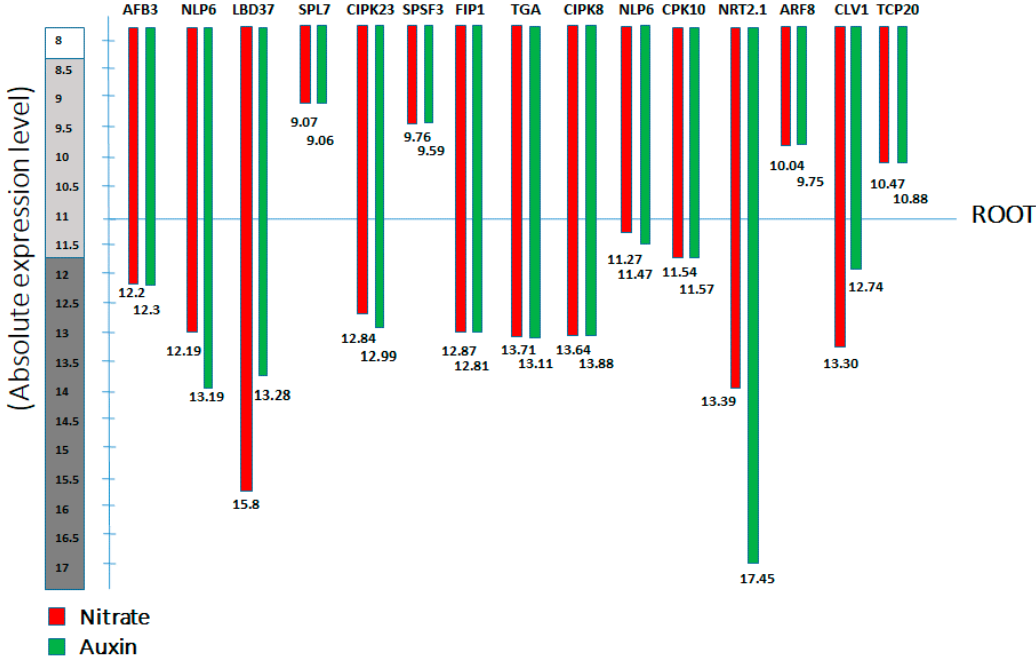
Figure 5. Affymetrix Arabidopsis ATH1 genome microarray analysis of the root; The schematic model represents the absolute expression level of the different nitrate transcription factors in the root of Arabidopsis , under nitrate (NO 3 − ) and auxin treatment, the red bar represents the gene expression for nitrate treatment, while the green bar represents the expression level for auxin treatments. (See text for further detail).